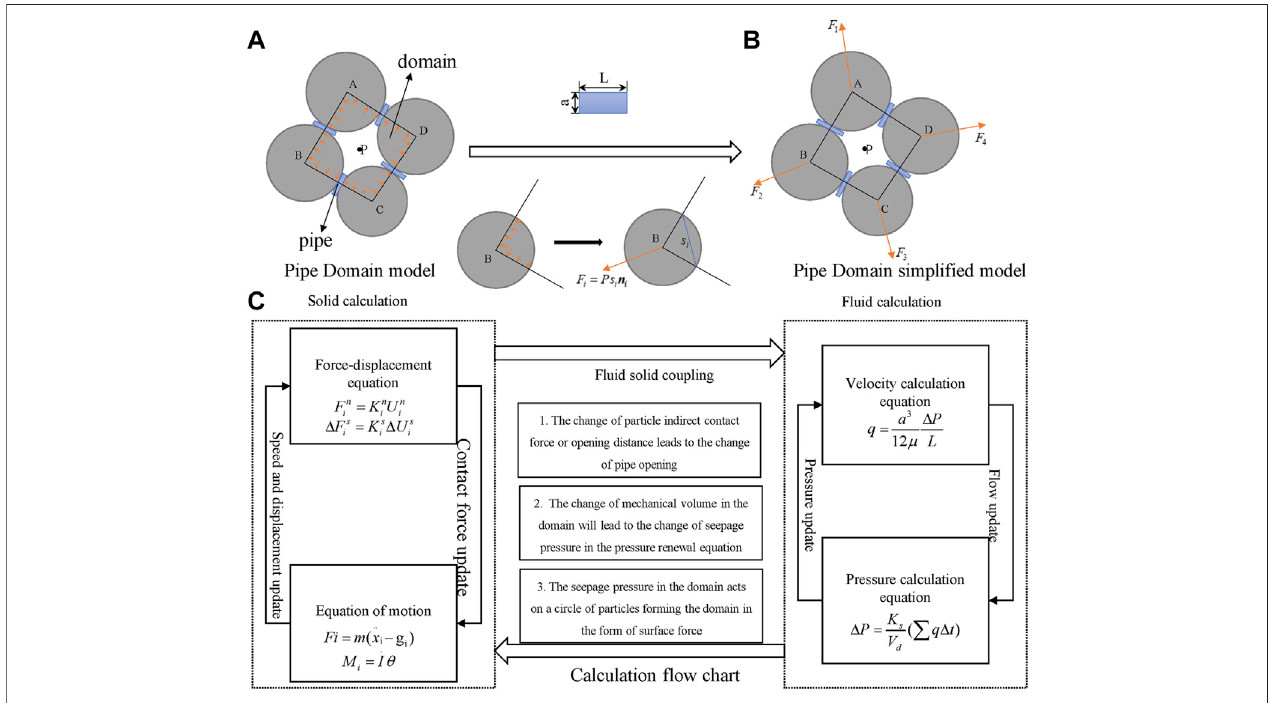
FIGURE 1 | Pipe domain model and calculation fl ow chart. (A) and (B) are the force diagram of fl uid pressure on particles, and (C) is the fl ow chart of fl uid solid coupling.